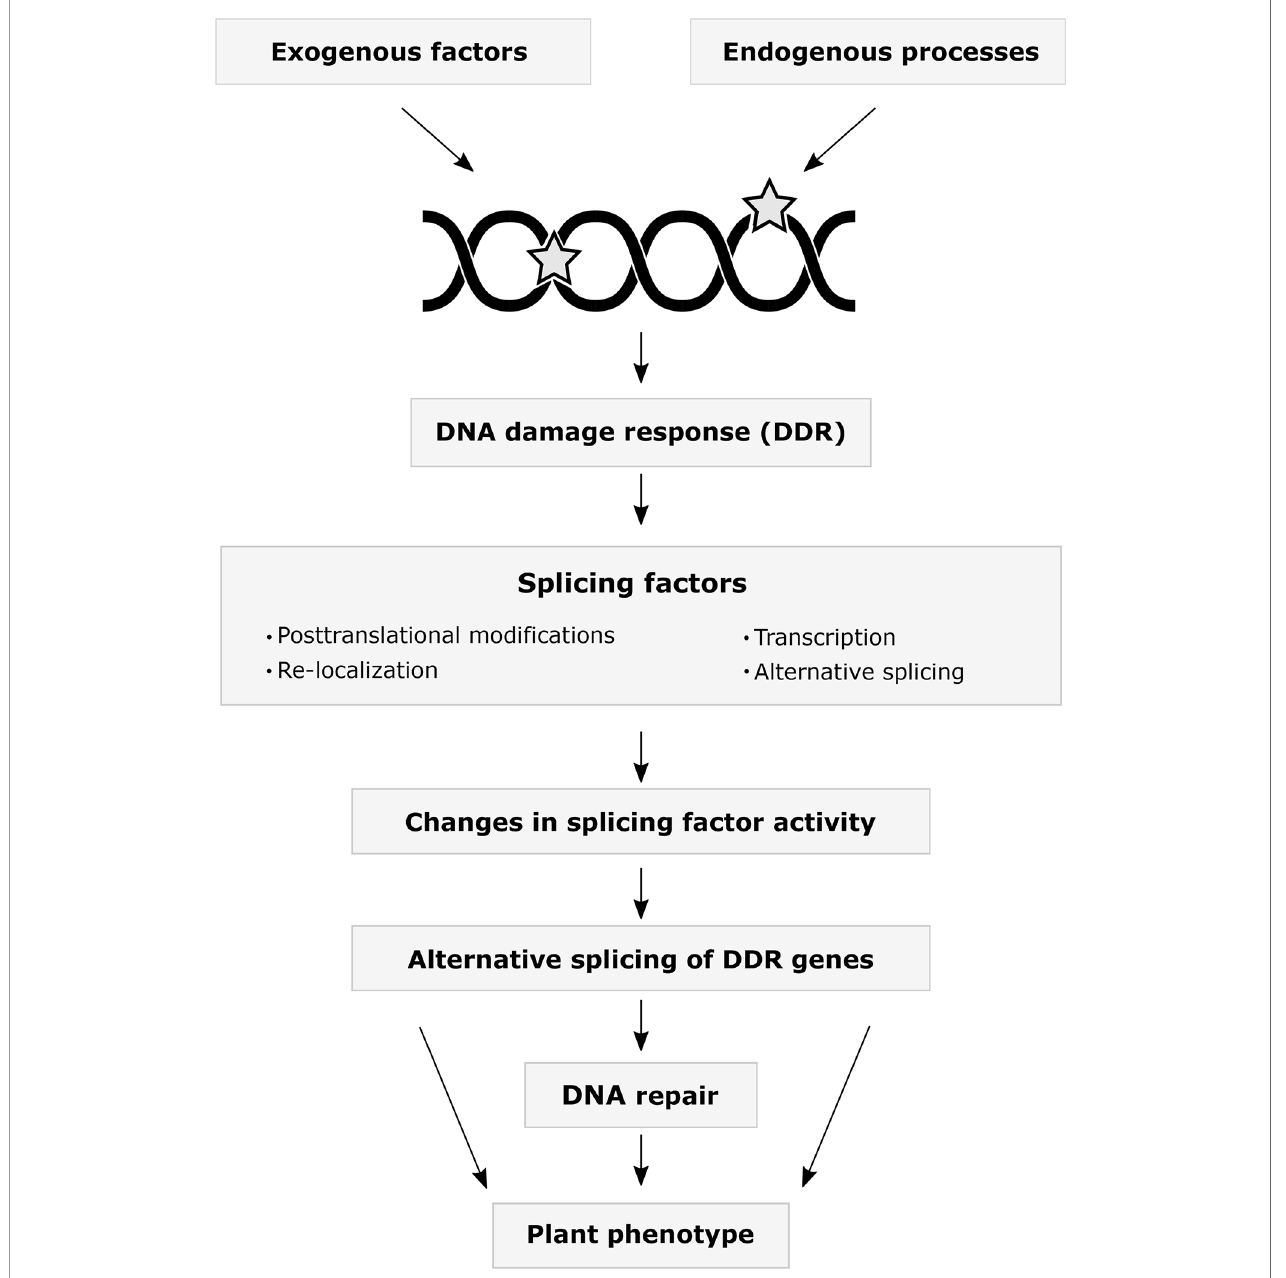
FIGURE 1 | The interplay between the DNA damage response and alternative splicing. A variety of exogenous environmental stress factors and endogenous cellular processes may result in DNA damage. Numerous studies on animals have demonstrated that splicing factors change their expression levels, alternative splicing patterns, post-translational modi fi cation states, and subcellular localization in response to DNA damage. Altered expression and activities of splicing factors may regulate DNA repair by modulating alternative splicing of DDR genes. Current data indicates that many plant DDR genes undergo alternative splicing. Which plant splicing factors are involved in the DDR, how they are regulated, what are their target genes, and how the splicing changes are translated into the plant phenotype remains to be addressed in the